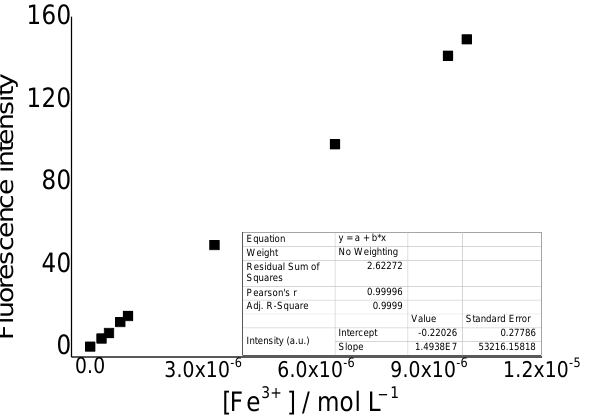
Figure 6. Linear calibration curve of NI2 in DMF solution (c = 1 × 10 − 5 mol L − 1 ) at various concentrations of Fe 3+ cations (from 0 to 1 × 10 − 5 mol L − 1 ) in the order of increasing intensity ( λ ex = 365 nm).